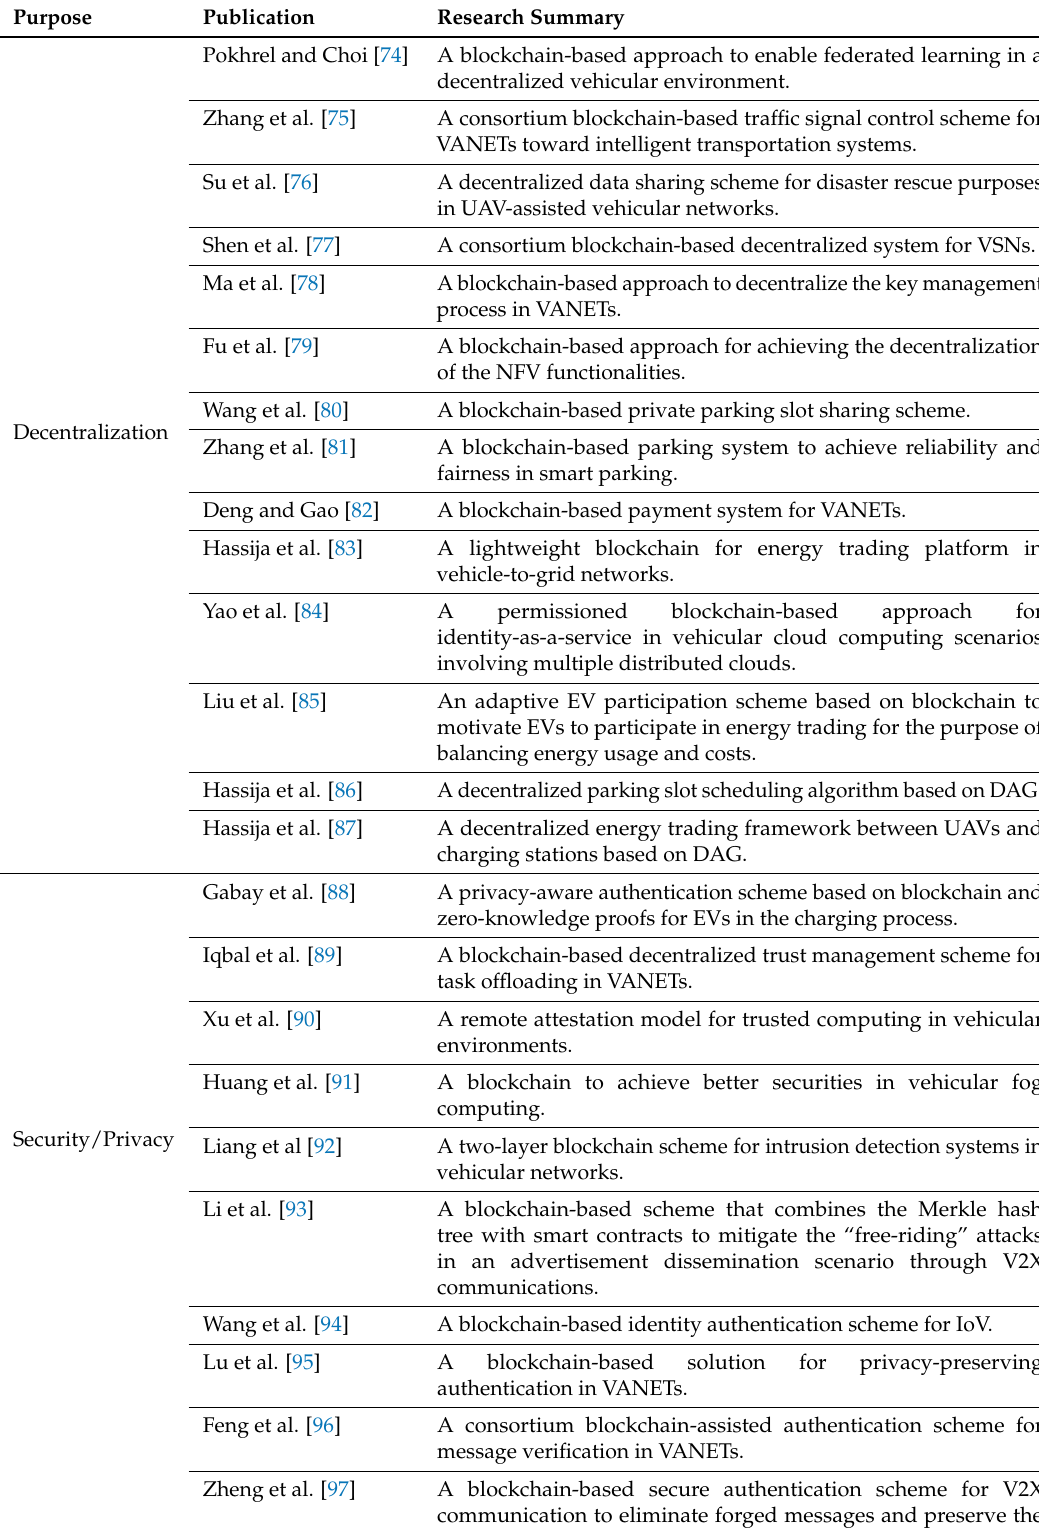
Table 4. Blockchain for application layer issues in vehicular IoT (Part